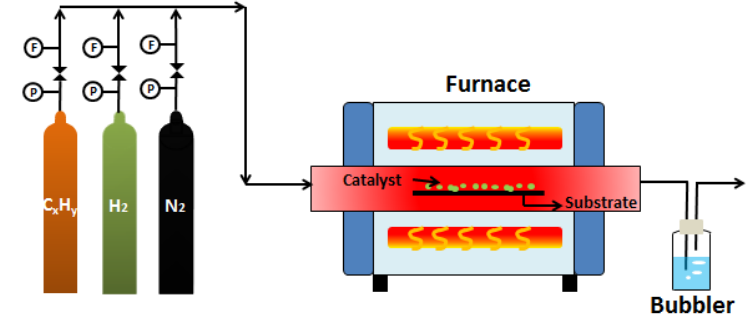
Figure 2. Schematic diagram of the experimental CVD equipment.